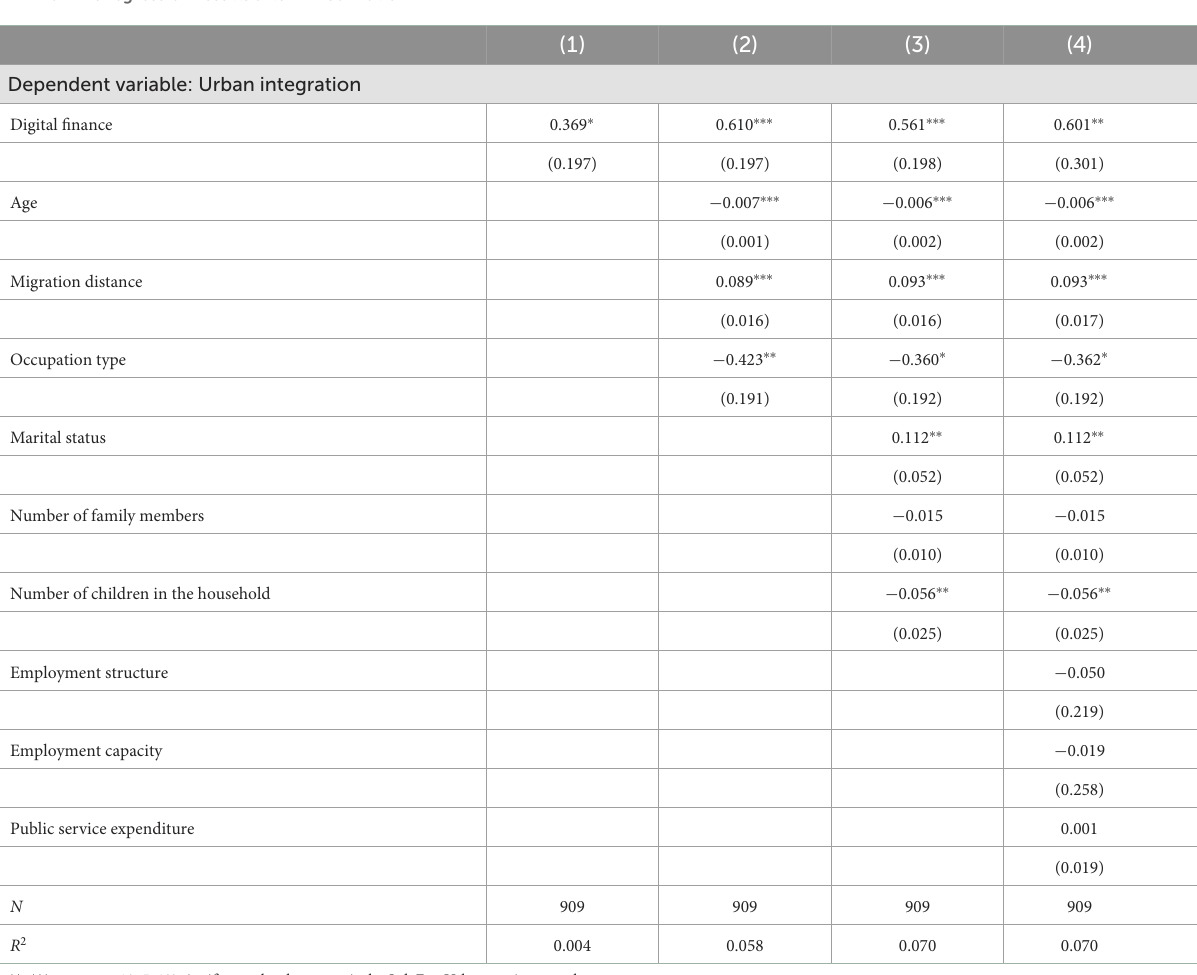
TABLE 5 The regression results after